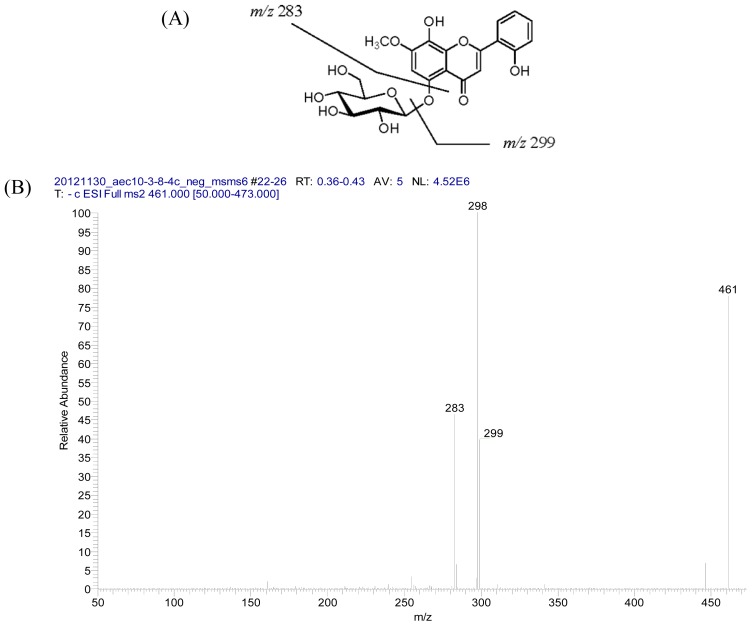
(A) Structure of 1 and main fragments under LC/MS/MS (negative ESI); (B) LC/MS/MS spectrum.